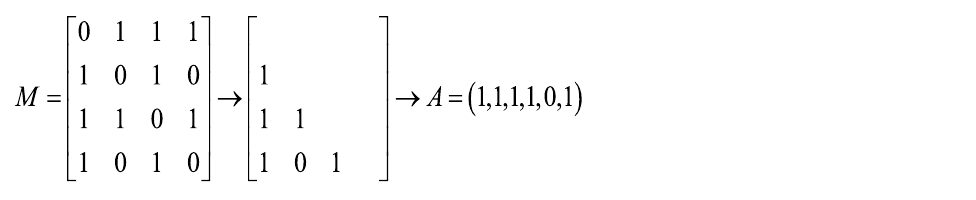
Figure 3. Vector of adjacency matrix.